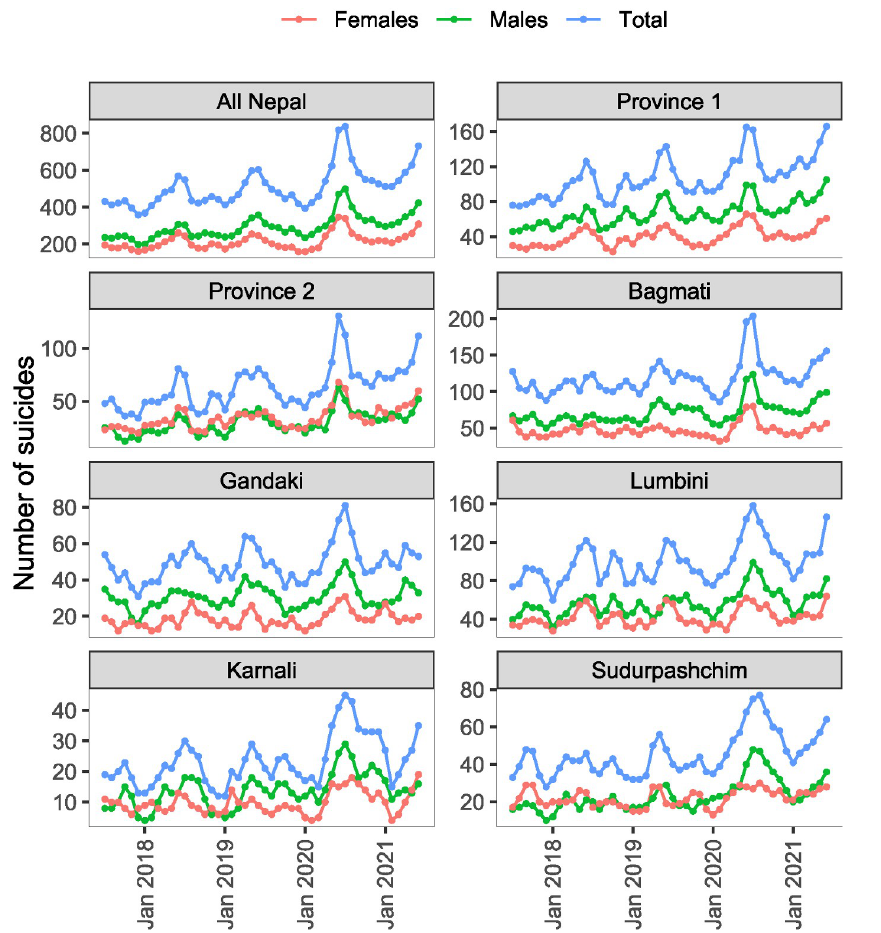
Fig 1. Monthly suicide deaths from July 2017 through June 2021 in Nepal by gender and